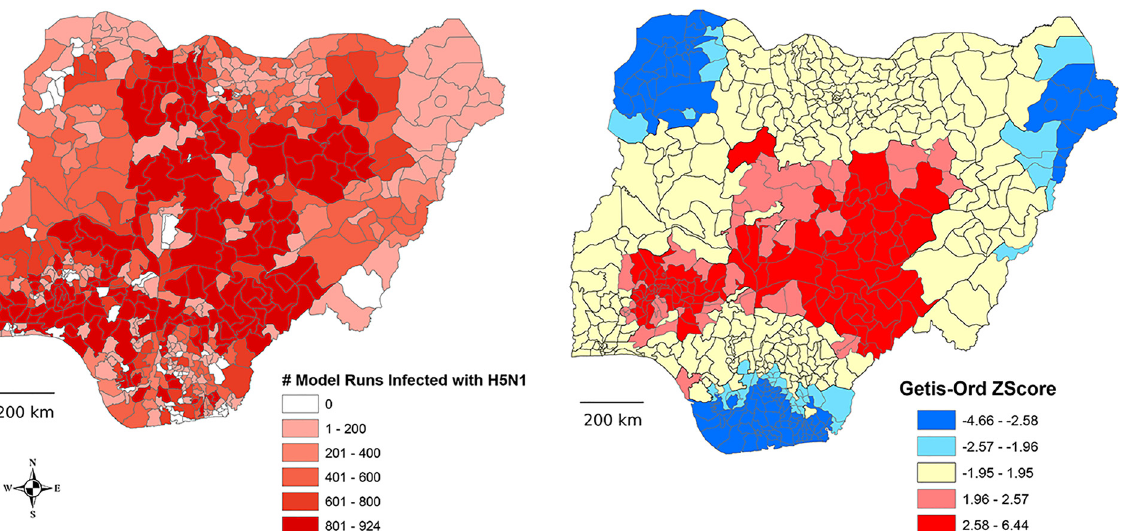
Fig 6. Validation of modeling results. A) The number of times a Local Government Association (LGA) was affected out of 1280 model simulations. B) Map overlay of 2006 H5N1 epidemic locations (black dots) with Z scores resulting from the Getis-Ord Gi * statistic as applied to model output. LGAs colored red are statistically “ hotter ” (more positive model simulations) while LGAs colored in blue are statistically “ colder ” (fewer positive model simulations) than their neighbors within a 200 km moving window. The relationship between simulated data and 2006 epidemic data was strong in that the number of times a LGA was affected by H5N1 in 2006 directly related to Gi * Z score values ( χ 2 = 74.82, df = 1, P <